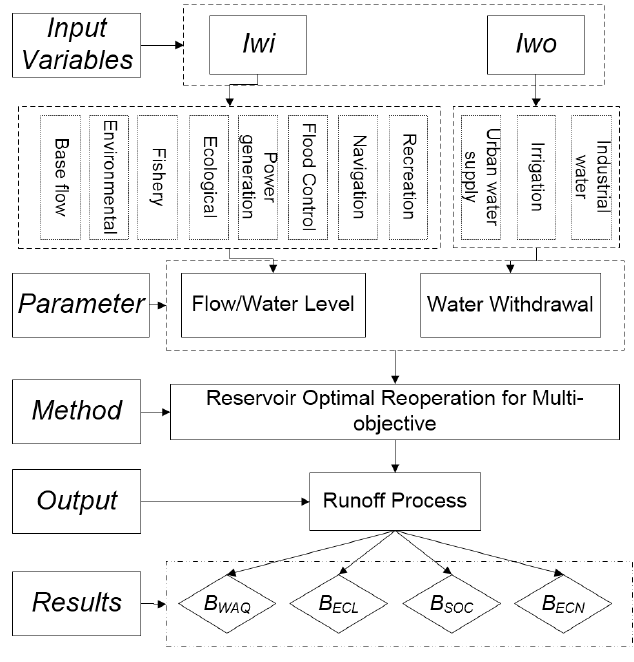
Figure 2. Overall model structure. Iwi , instream water use variable; Iwo , water use variable outside the river; t , time domain; B , water quality benefits; B WAQ B , social benefits; B , economic SOC ECN